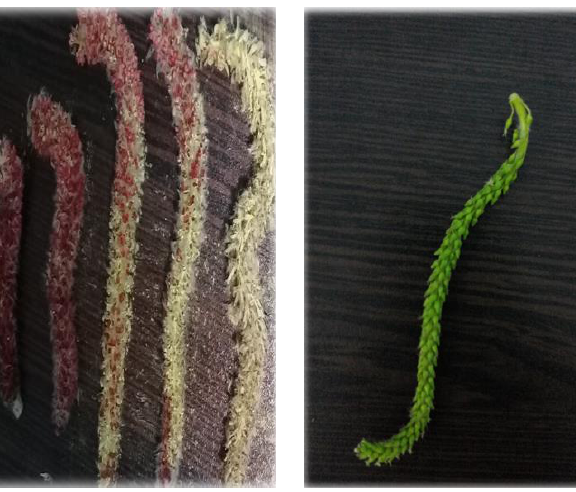
Figure 3 . Caspian poplar flowers: right) Female flower, left) Male